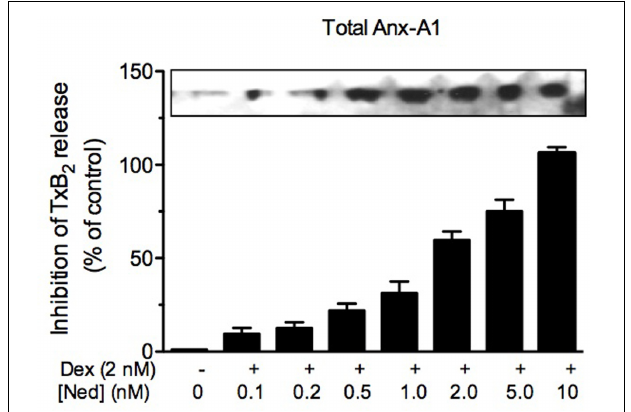
FIGURE 1 | Nedocromil potentiates dexamethasone inhibition of TxB 2 release from U937 cells. The increased internalization of Anx-A1 (as assessed by western blotting) and concomitant inhibition of TxB 2 release (as assessed by ELISA assay) produced by escalating concentrations of nedocromil (0.2–10 nM) in the presence of a fixed concentration (2 nM) of dexamethasone. Figure reproduced with the permission from the rights holder, Elsevier (Yazid et al.,